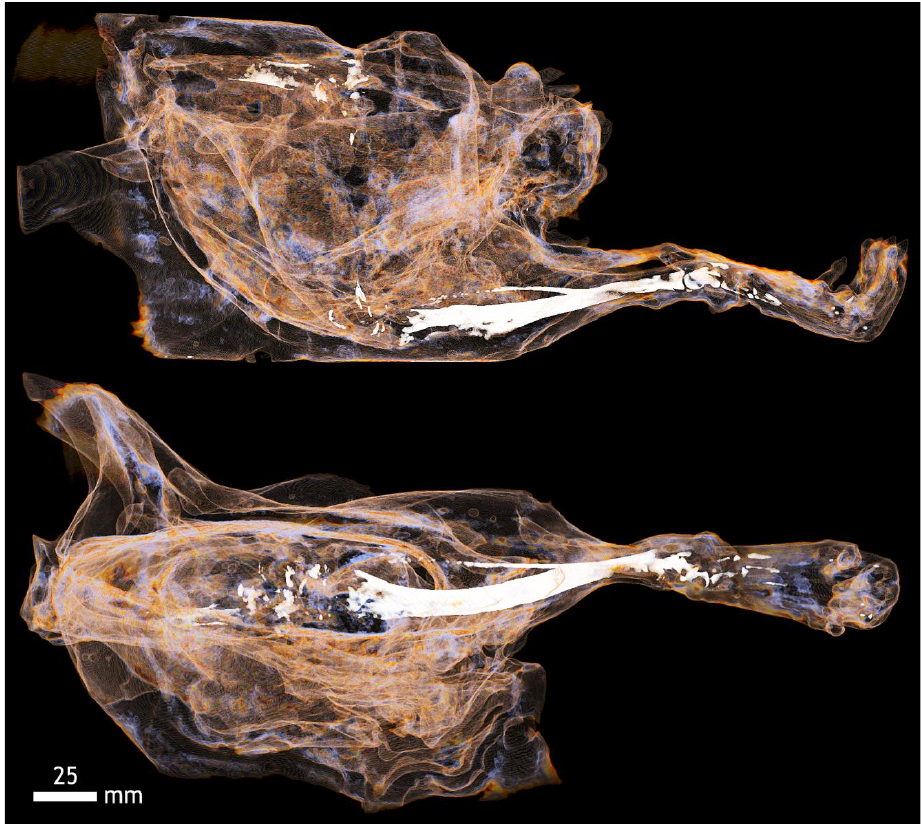
Figure A16. Contrast of fascia muscle groups on the hind limb of mice with KI and 20% ethanol. The bones of the limb can be seen in detail, including the small tarsal bones of the foot.